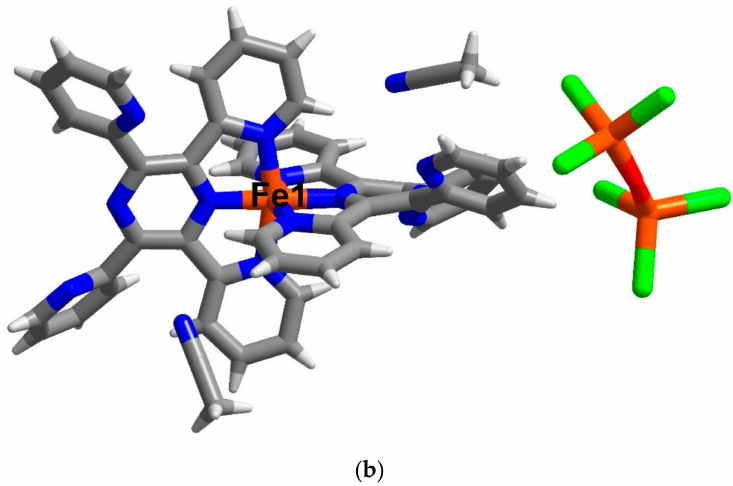
Figure 3. The asymmetric unit of compound ( a ) 2 and ( b ) 3 at 123 and 100 K, respectively. Colour code (element): brown (iron), red (oxygen), blue (nitrogen), grey (carbon) and white (hydrogen), green